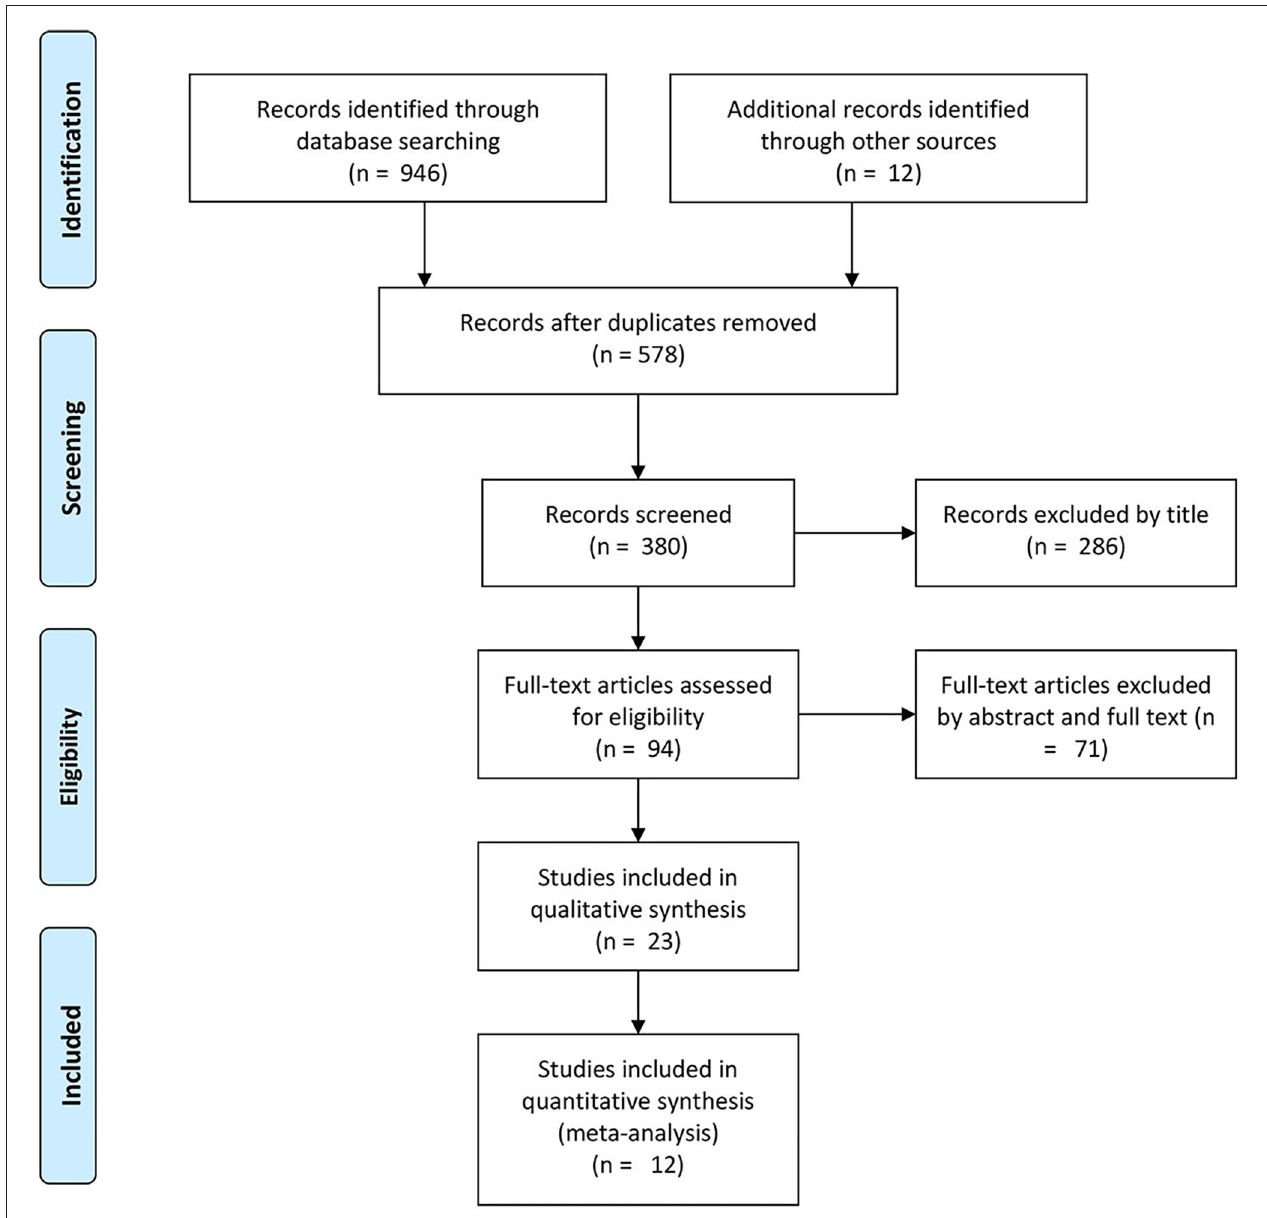
FIGURE 1 | A flow chart of the study